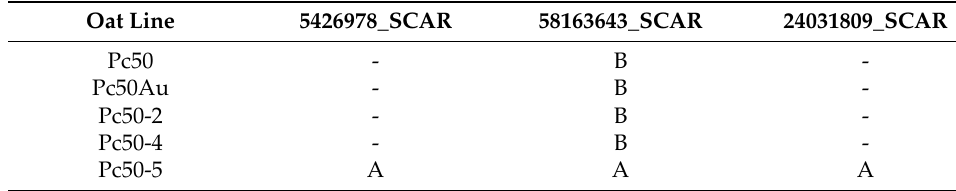
Table 4. PCR markers validation on Pc50 isolines (Pendek × CW 486-l).